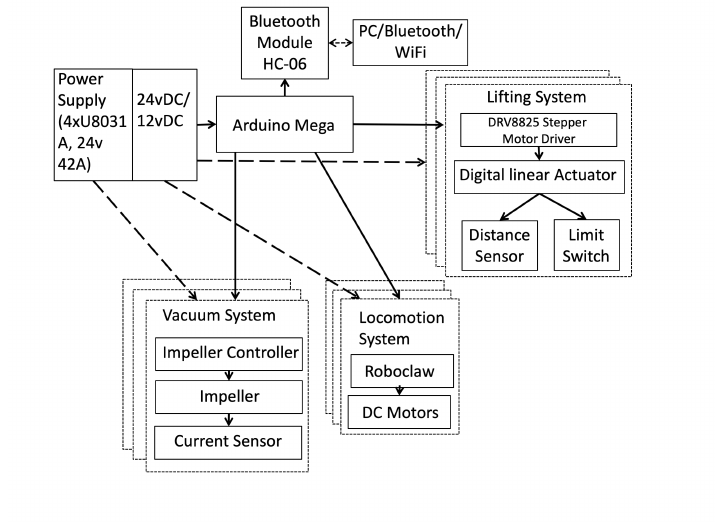
Figure 3. Diagram of the system architecture for Mantis ’s